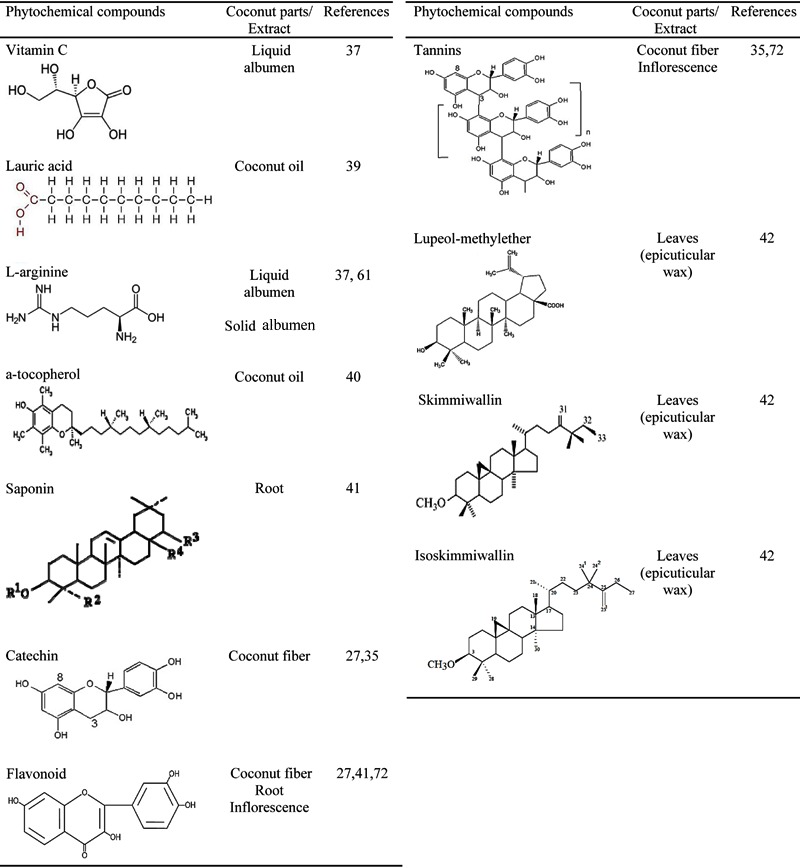
Structures of the main phytoconstituents isolated from Cocos
nucifera (L.).